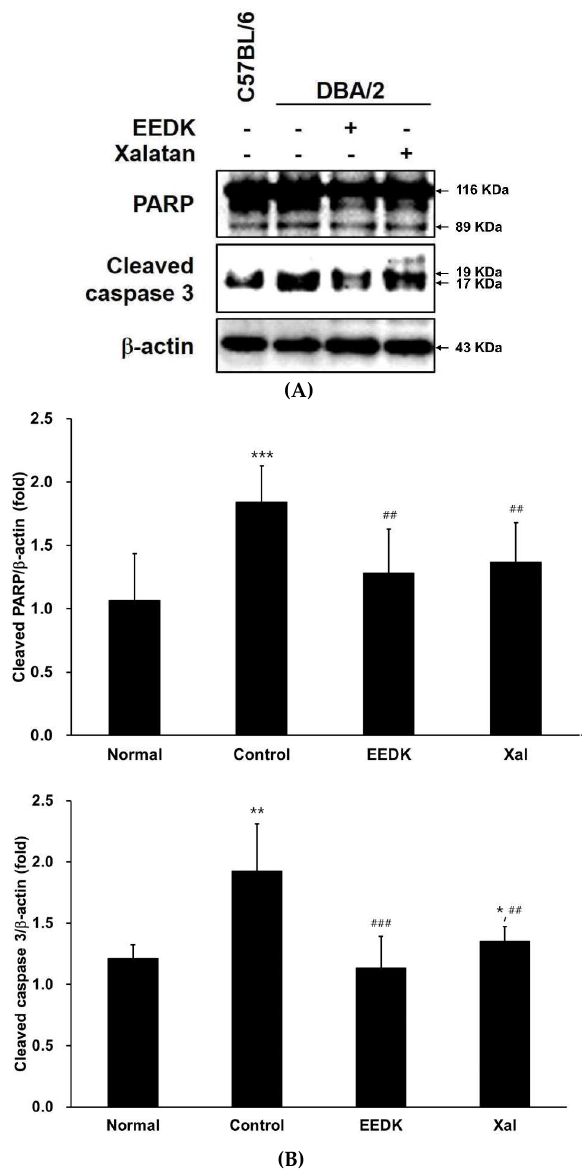
Figure 8. Effect of EEDK on apoptotic protein expression in DBA/2 mouse. ( A ) Expression of apoptotic proteins: PARP and cleaved caspase-3, and β -actin (control) in DBA/2 mouse retinas by western blot. ( B ) Densitometries of cleaved PARP and cleaved caspase 3 protein bands were measured with Image J. Values represent the mean ± S.E.M. of 6 – 8 animals. Values of * p < 0.05, ** p < 0.01 and *** p < 0.001 indicate significant difference between each group compared with normal group. Meanwhile, ## p < 0.01 and ### p < 0.001 correspond to difference between the EEDK- or Xalatan-administered group with control group.